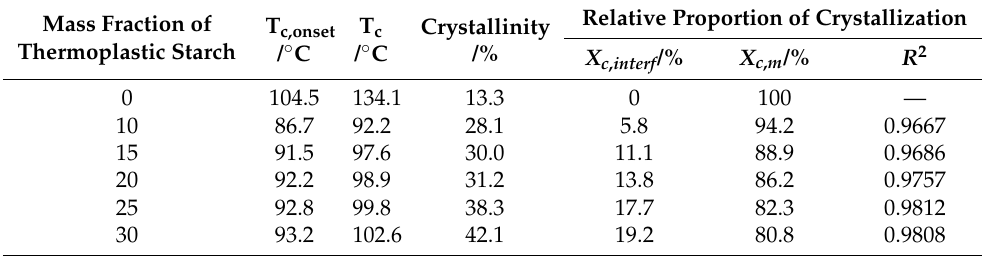
Table 2. The relative crystallization of PLA on its interface with thermoplastic starch and in its matrix. Mass Fraction